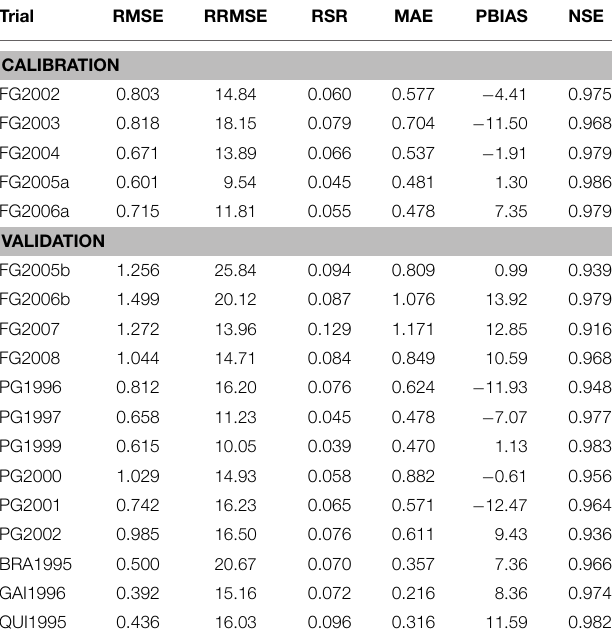
TABLE 3 | RMSE, Root mean square error; RRMSE, relative root mean square error, RSR, RMSE-observation standard deviation ratio; MAE, mean absolute error; PBIAS, percent bias; Nash-Sutcliffe efficiency (NSE) for the fittings performed on progression of shoot dry weight (SDW) in calibration and validation trials.